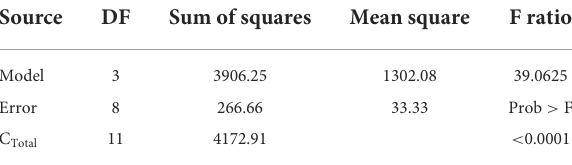
TABLE 6 Variance analysis of experimental design results.